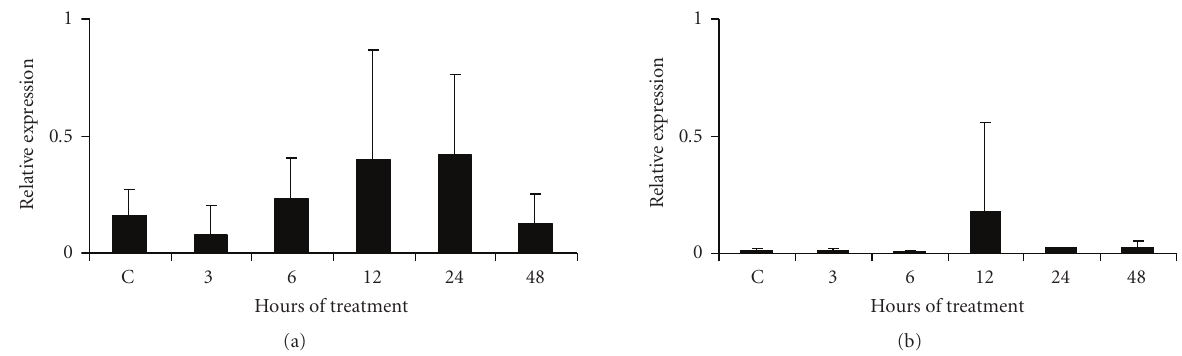
Figure 5: Semiquantitative analysis of NALP12 and NALP5 mRNA expression in the eye LPS-treated mice . NALP12 (panel (a)) and NALP5 (panel (b)) mRNA expression were determined by RT-PCR. Mice were treated with LPS during 3, 6, 12, 24, and 48 hours. Average of 5 mice analyzed in each assayed time is reported. Analysis of Kruskal-Wallis test showed no statistical